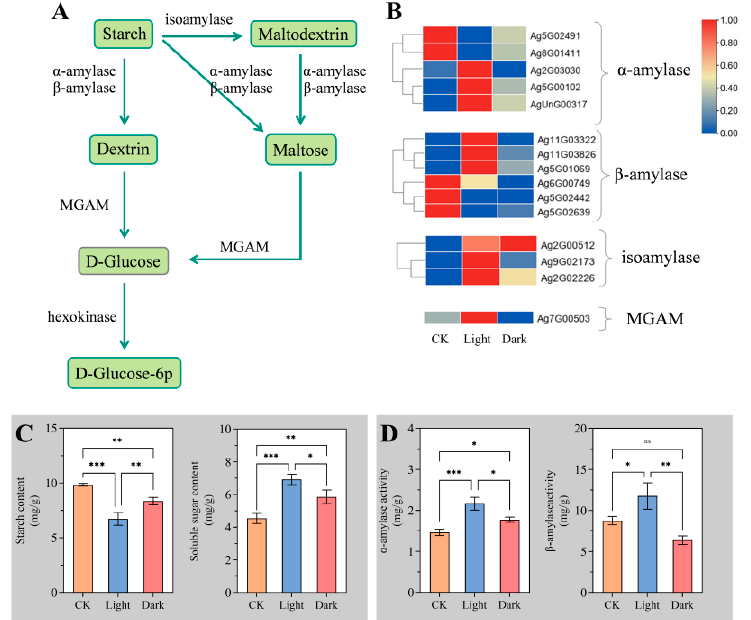
Figure 5. Starch metabolism, sugar content, and amylase activity. ( A , B ) Starch metabolism and expression of related metabolic enzyme genes. ( C ) Starch and soluble sugar content. ( D ) α -amylase and β -amylase activity. The transcripts of DEGs were normalized as 0–1. Gene IDs are shown by the legend on the right. Expression levels ranging from red to blue indicate high to low expression for genes, respectively. * p < 0.05, ** p < 0.01, *** p < 0.001, “Tukey’s” test. ns represents no difference. Vertical bars indicate means ± SD (n = 3).